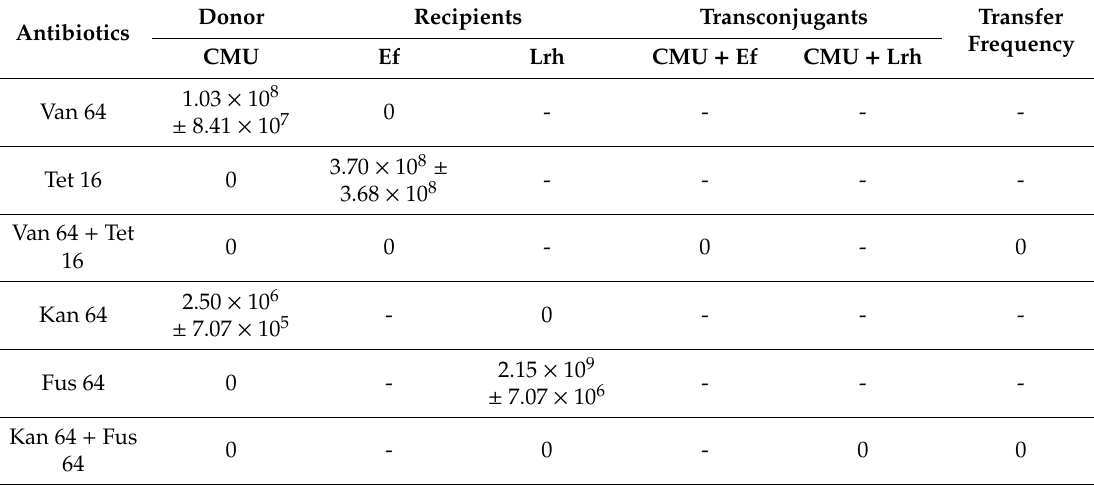
Table 3. Transferability of vancomycin and kanamycin resistance from donors ( W. cibaria ) to recipients ( E. faecalis and L. rhamnosus ) (CFU /